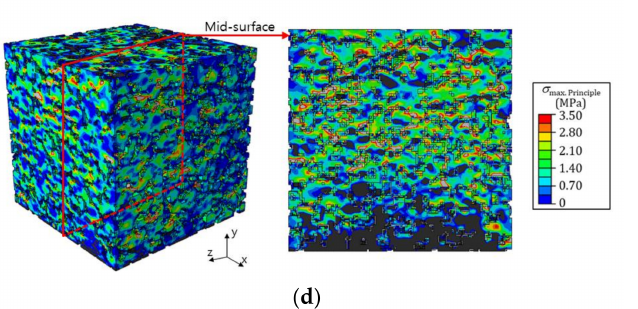
Figure 11. Stress distribution of PPM specimens under uniaxial compressive loading: ( a ) G33, ( b ) G45, ( c ) G60, and ( d )